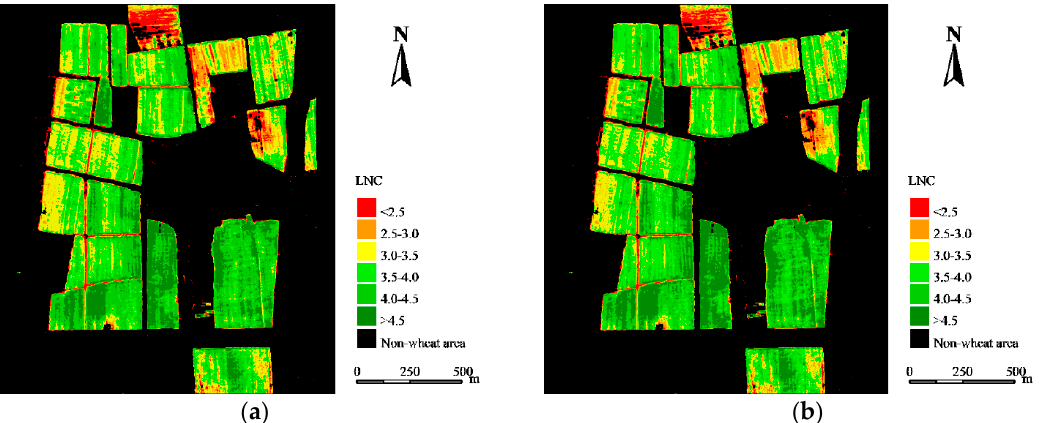
Figure 6. Ground-measured nitrogen content versus the values estimated from the inversion model: ( a ) estimated by FD-NDNI and ( b ) estimated by FD-SRNI. The ground-measured LNC values of synchronous sampling at the time of remote sensing image acquisition were used for the accuracy test. The estimated and ground-measured values in the same location were compared by regression fitting (Figure 7). As seen from the figure, FD-NDNI yields an accuracy of R 2 = 0.721 and RMSE = 0.540 for 30 sites with LNC values ranging from 1.85% to 4.71%. For FD-SRNI, the estimation yields an accuracy of R 2 = 0.720 and RMSE = 0.495 with LNC values ranging from 1.87% to 4.74%. Furthermore, the relationships between the estimates and ground-based measurements both have a slope close to 1 (0.782 for FD-NDNI and 0.864 for FD-SRNI) and a small interception (0.512 for FD-NDNI and 0.357 for FD-SRNI), which indicates that the modeling approach produces systematically fair estimations.